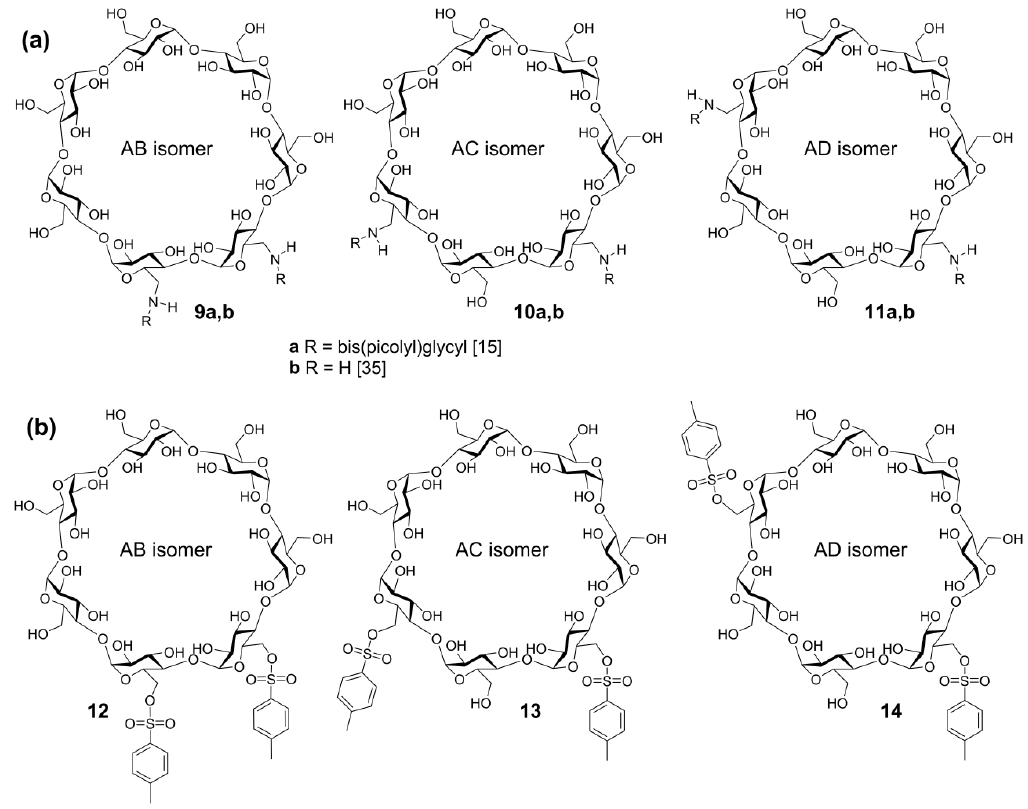
Figure 10. Structures of disubstituted β -cyclodextrins AB, AC, and AD ( a ) di(bis(picolyl)glycyl)amides 9a – 11a , diamines 9b – 11b ; ( b ) di- O -tosylates 12 – 14 [15,36]). (Reproduced with changes from [36] with permission of Springer).